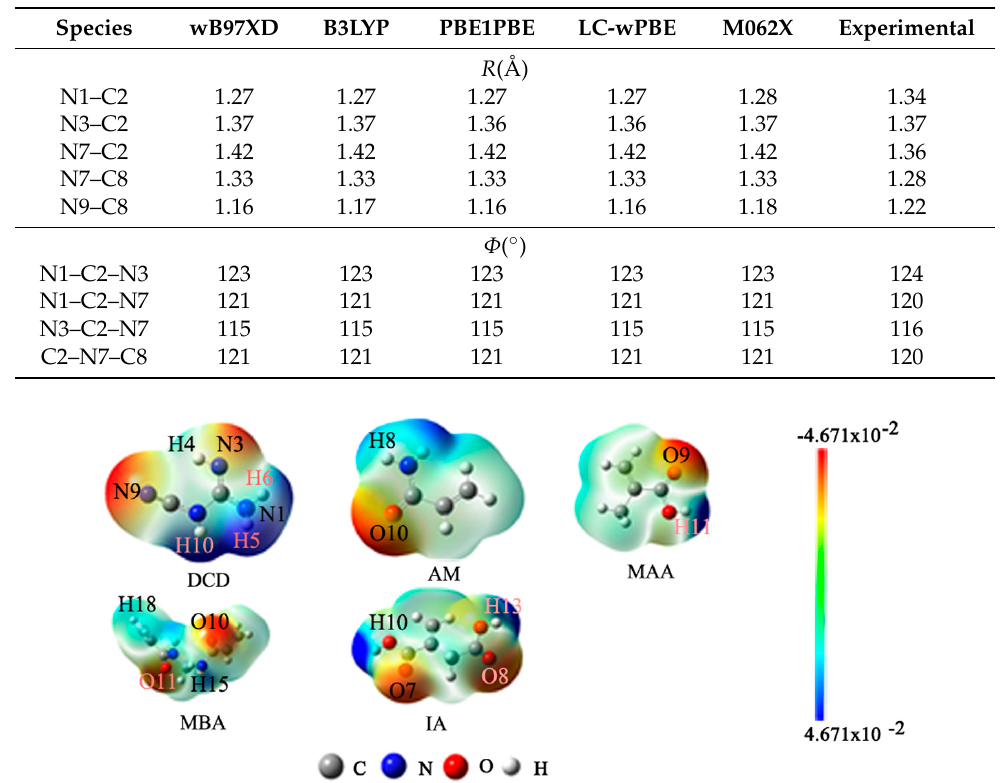
Table 1. The calculated (at the wB97XD, B3LYP, PBE1PBE, LC-wPBE, and M062X levels with the 6-31G(d,p) basis set) and experimental structural parameters of DCD.